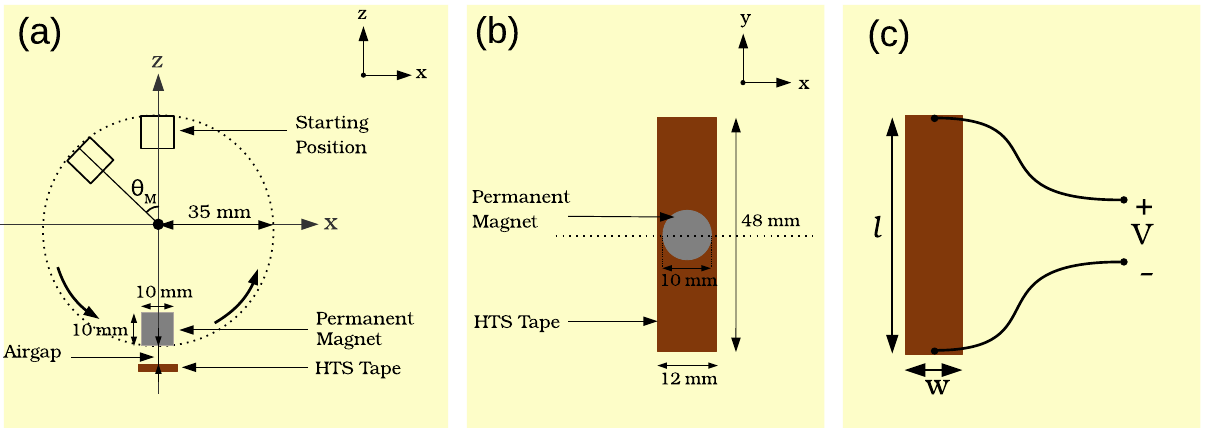
Figure 2. Configuration of the 3D model: ( a ) view from xz -plane, ( b ) view from xy -plane, ( c ) qualitative sketch of the voltage